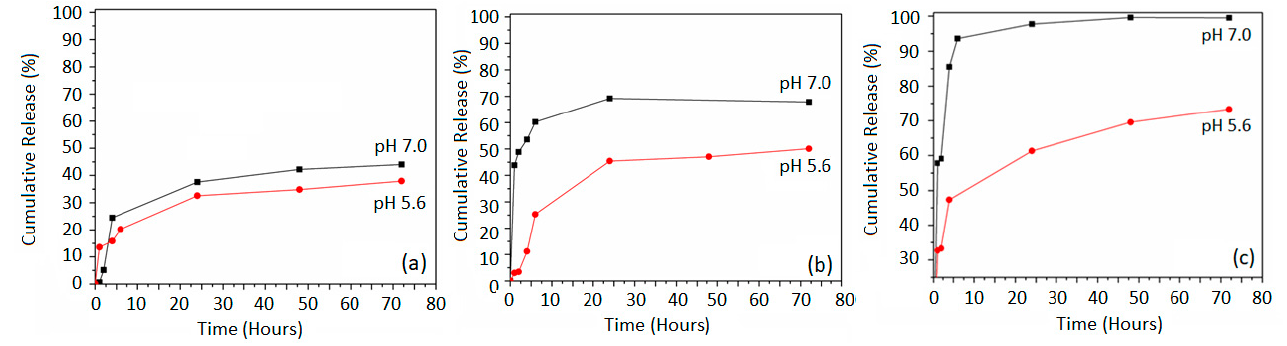
Figure 7. Cumulative release study of crocetin-functionalized pegylated MNPs at di ff erent pH val- ues: ( a ) 5×-Cro-PEG-MNP, ( b ) 10×-Cro-PEG-MNPs, ( c ) 20×-Cro-PEG-MNP . ( a ) 5 × -Cro-PEG-MNP, ( b ) 10 × -Cro-PEG-MNPs, ( c ) 20 ×